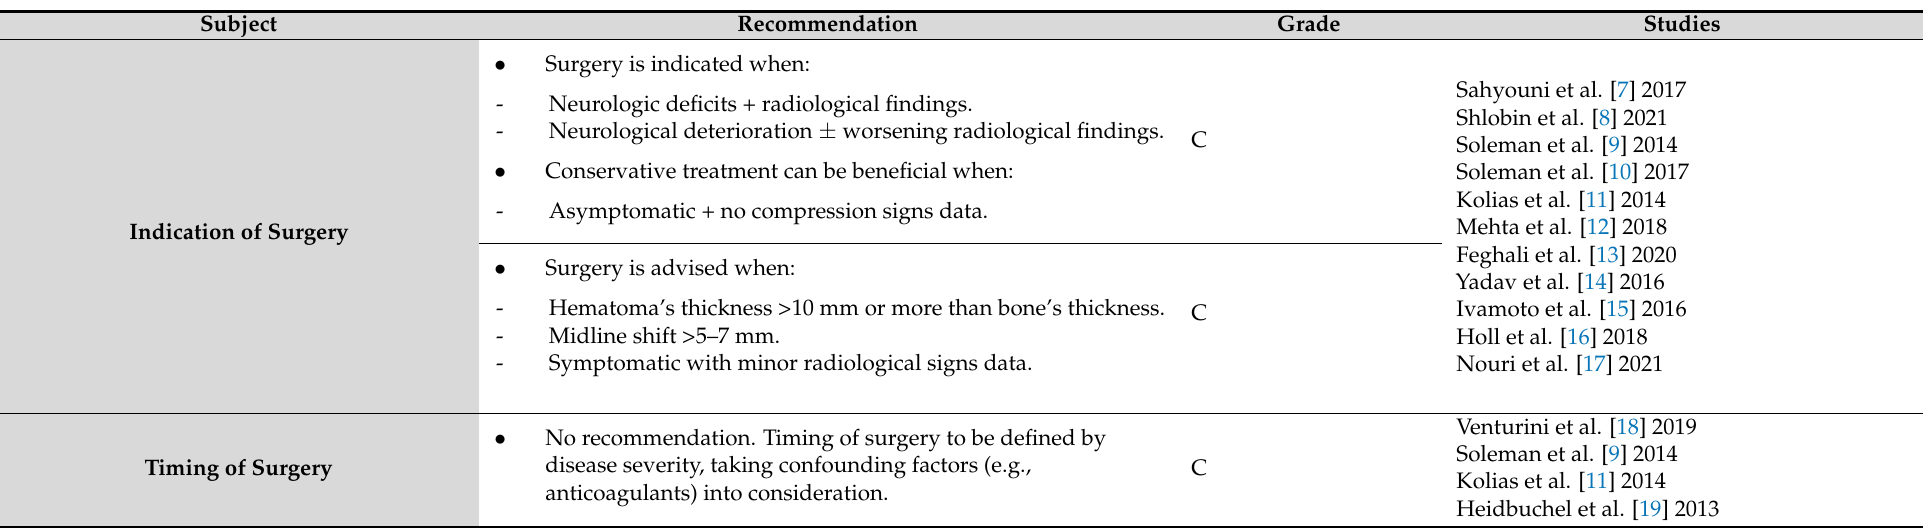
Table 2. Controversies and recommendations regarding the surgical treatment of chronic subdural hematoma (cSDH). Strength of recommendations adopted from the guidelines of the American Academy of Neurology and Weigel et al. 2012